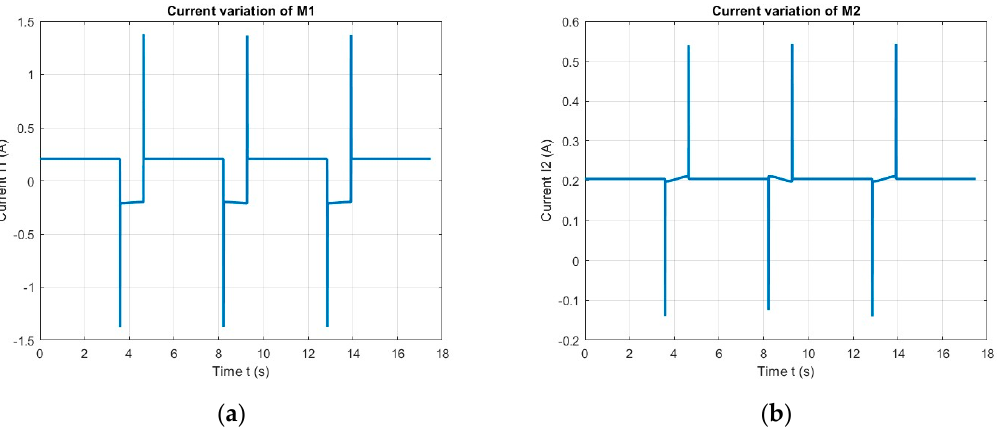
Figure 38. Current variation simulated for a 1 m square path. ( a ) Wheel 1. ( b ) Wheel 2.